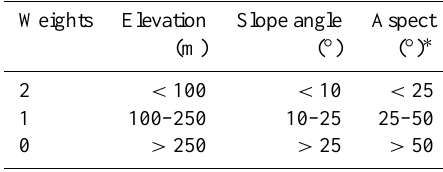
Fig. 2. Spatial distribution of permafrost evidence data (Cremonese et al., 2011), which were not used for model calibration in Boeckli et al. (2012) and are thus available for evaluation. Blue dots repre- sent rock glaciers, and red crosses represent evidence points (sum- marized in Table 3). Table 2. Thresholds and corresponding weights per variable that were used to characterize the agreement of the terrain attributes (PF loc ) for the evaluation data. The weight for the variable aspect for slope angles ≤ 15 ◦ (derived from ASTER GDEM) was fixed to 2, because uncertainties in this variable are large for flat